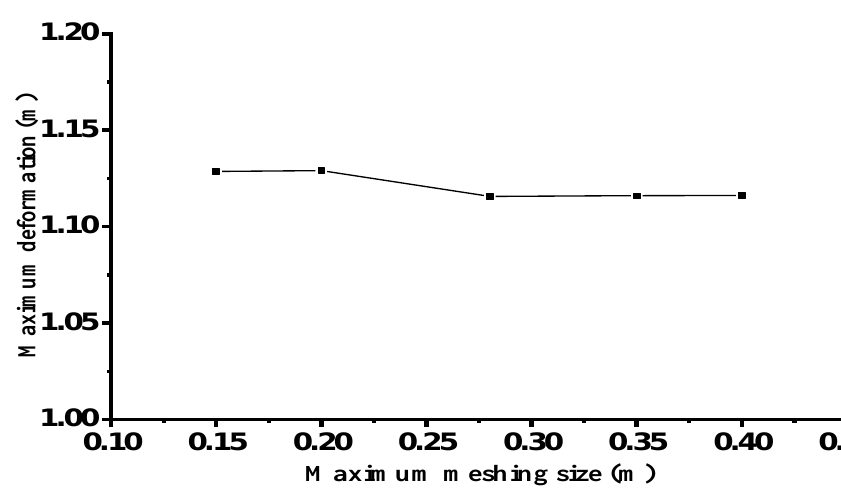
Figure 8. Maximum total deformations with mesh sizing.